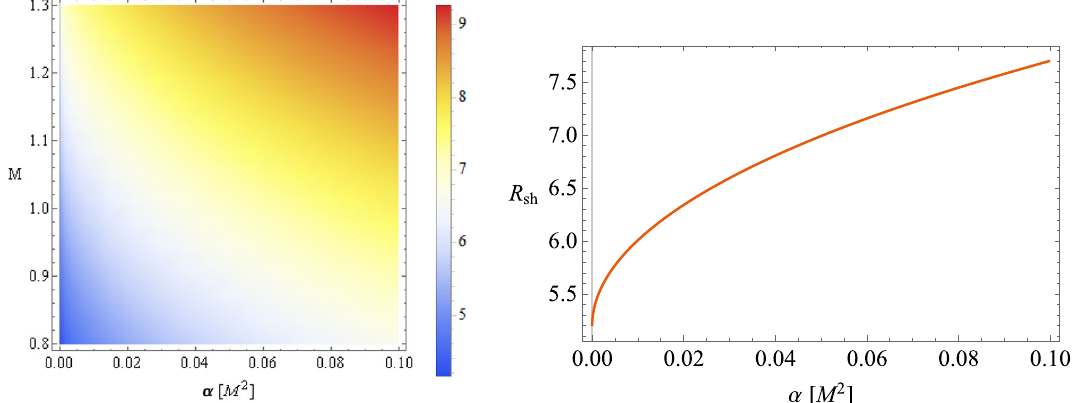
Fig. 1 Left panel: Density plot of the shadow R sh as a function of the parameter M and α for the metric described by (12). Right panel: Shadow radius as a function of α with a fixed mass M = 1 and thus we have X 2 + Y 2 = ξ 2 ( r ph ) + η( r ph ) . Hence,